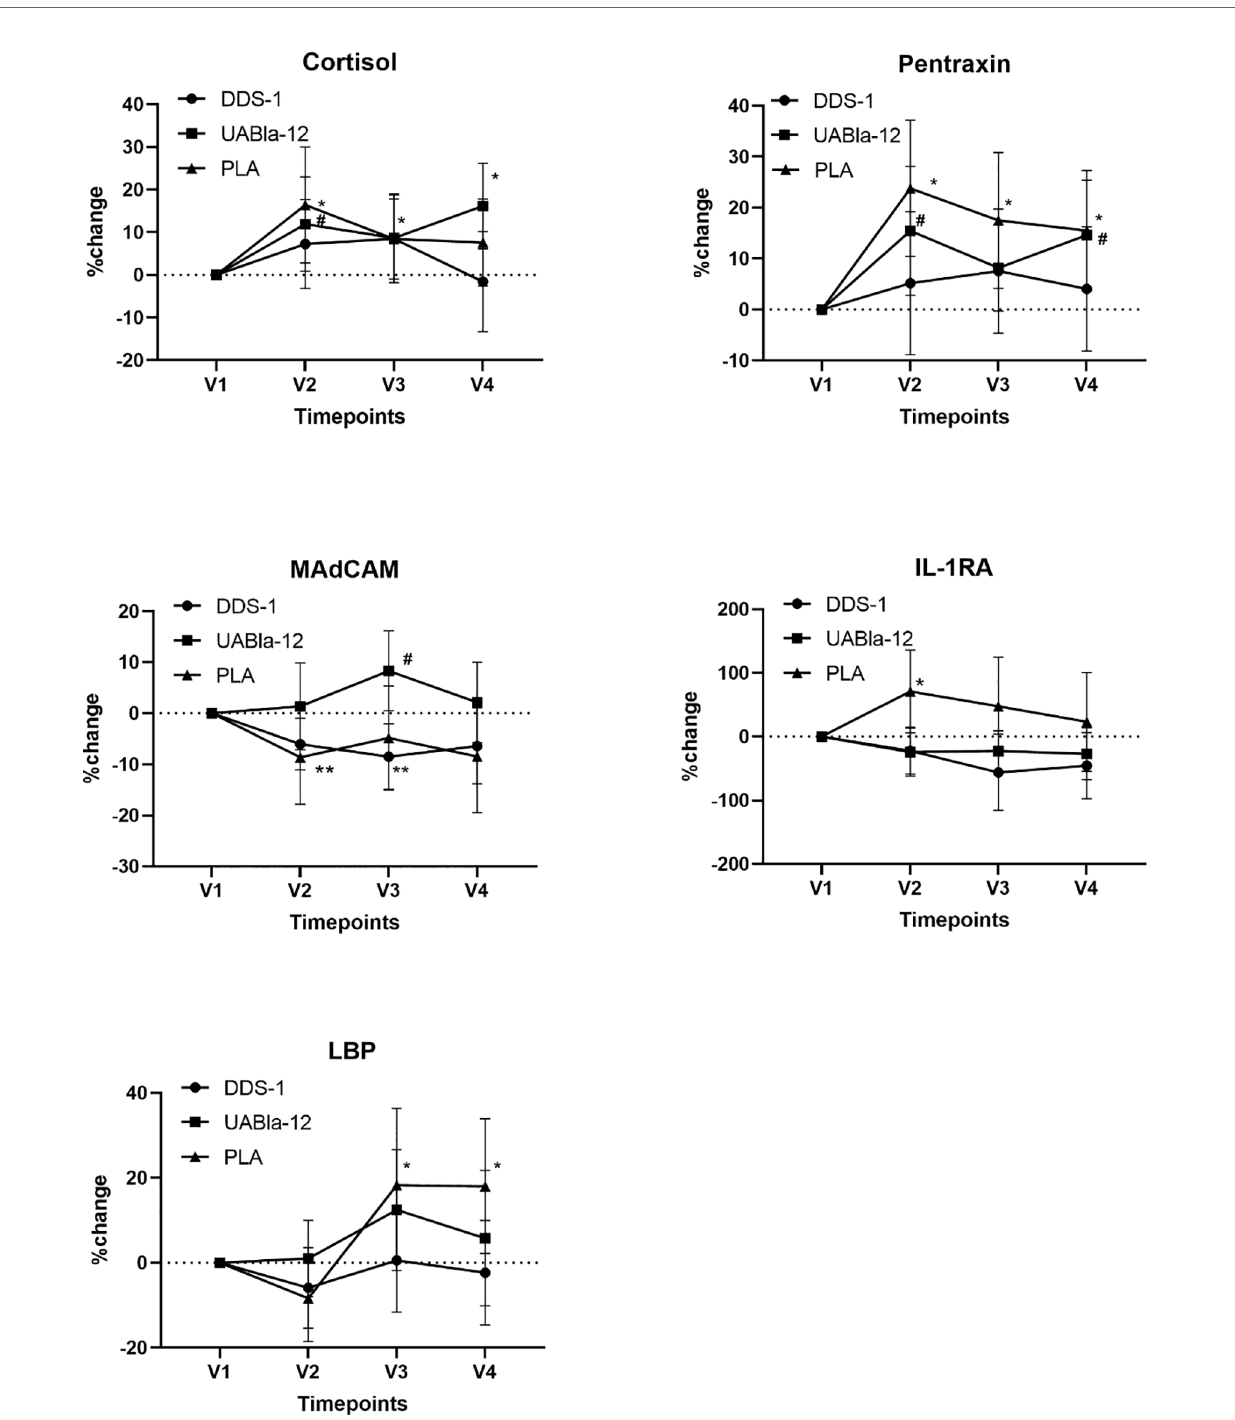
FIGURE 2 | Changes in the concentration of serum analytes over the course of the study. Signi fi cantly larger within group changes in the placebo group are evident in all analytes from V1 to V2. Data are % change and 95% CI. The large changes in these analytes while adhering to typical night-day sleep-wake cycle were greater than the effect of nightshift on indices of stress, the acute phase response, serum cytokines and intestinal integrity markers. *signi fi cant change from V1 in the placebo group, # signi fi cant change from V1 in UABla-12 group. **signi fi cance chance from V1 in the DDS-1 group.